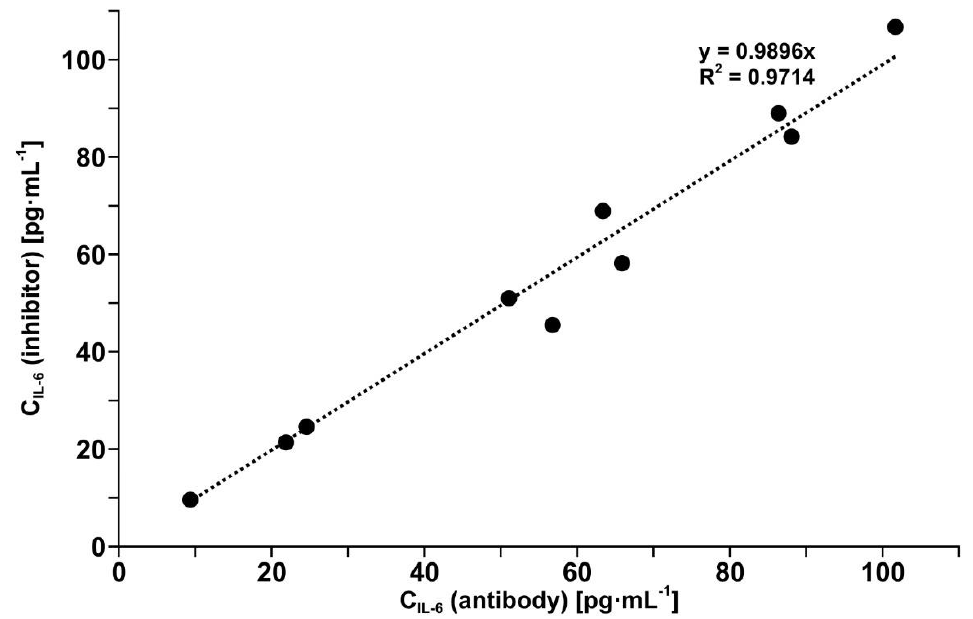
Figure 4. Comparison of results of IL-6 determination in blood plasma as determined by the biosensor with mouse monoclonal anti-IL-6 antibody and the biosensor with the inhibitor galiellalactone. The comparison shows that the results obtained using the biosensor with the antibody as the receptor and using the biosensor with the inhibitor as the receptor are equivalent (R 2 = 0.97 and slope close to 1). It is worth noting that the structures of the two biosensors are entirely